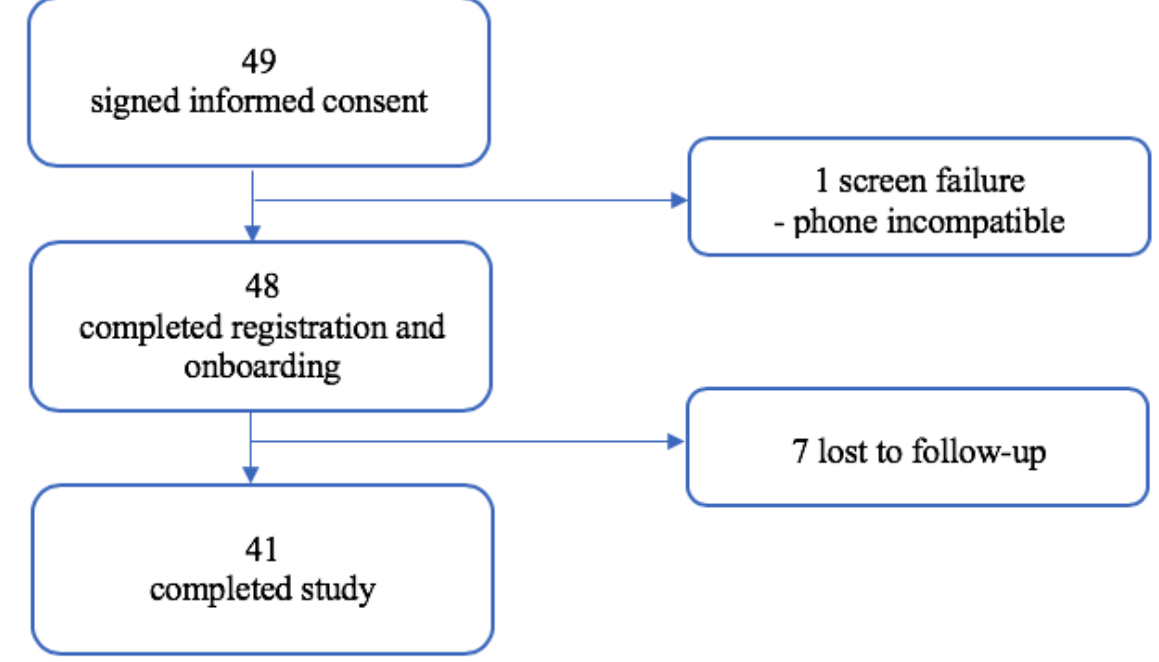
Figure 1. Consort (Consolidated standards of reporting trials) flow diagram of